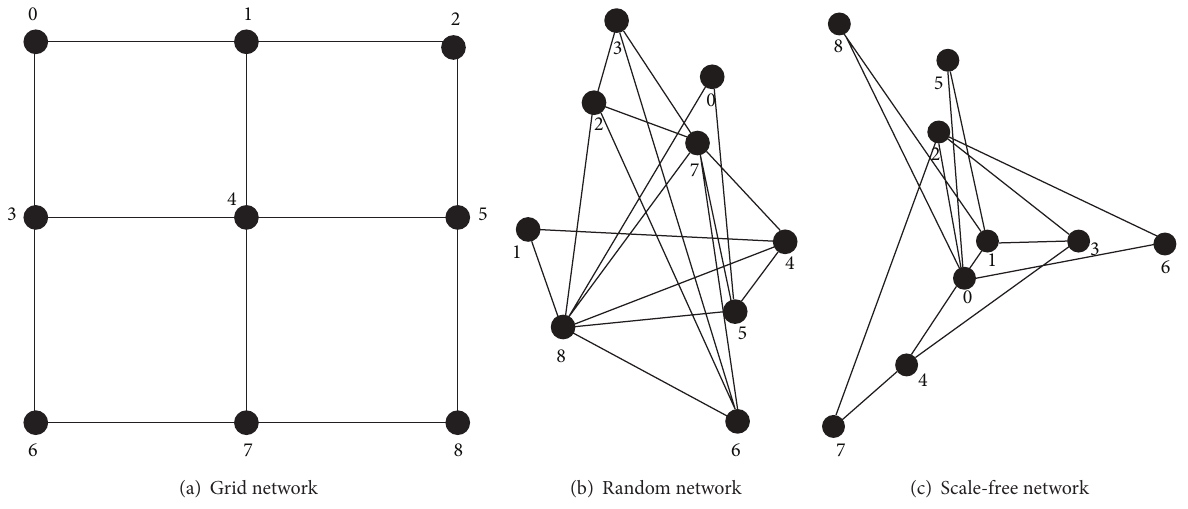
Figure 2: Mobile network topology.